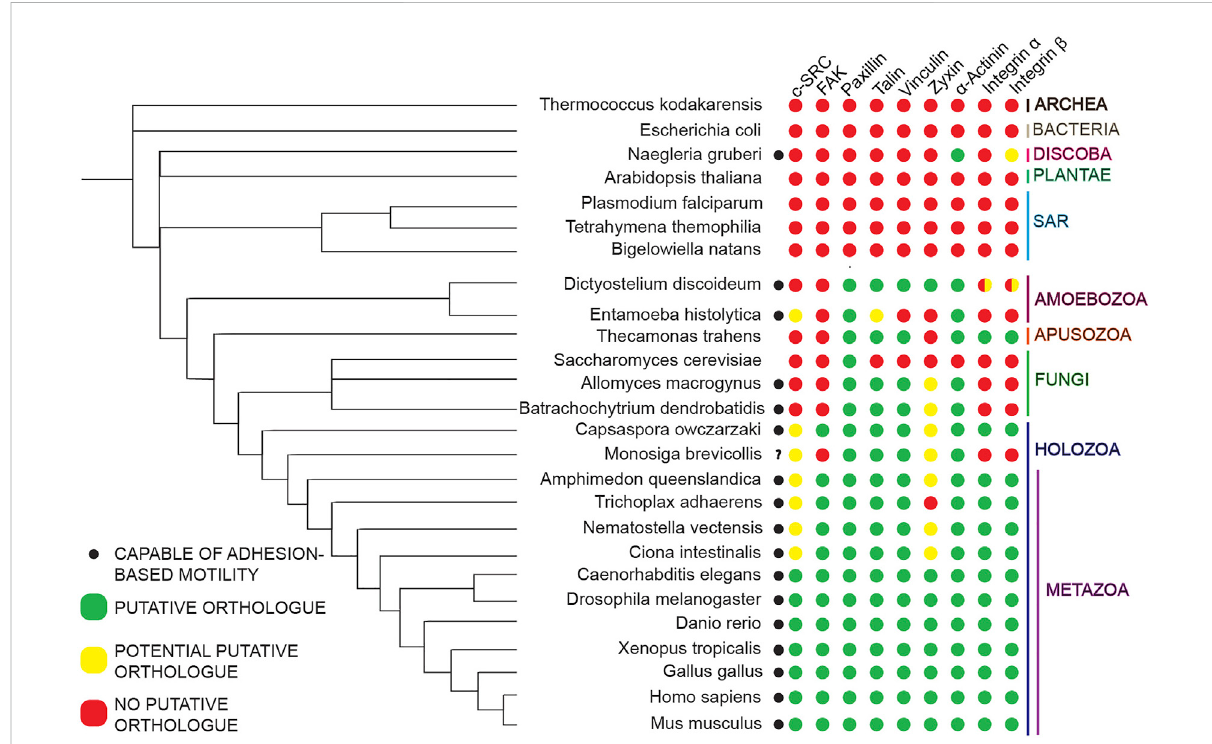
FIGURE 2 Non-metazoan organisms possess homologues of some but not all core Metazoan focal adhesion components. Bidirectional BLASTP was utilized to map the presence and absence of homologues of core Metazoan focal adhesion components of interest in representative species across evolutionaryspace.Thepresenceandabsenceofthesehomologues,asindicatedbythecoloreddots(legendtotheleft),ismappedagainstaspecies tree derived and expanded from previous work (Velle and Fritz-Laylin,